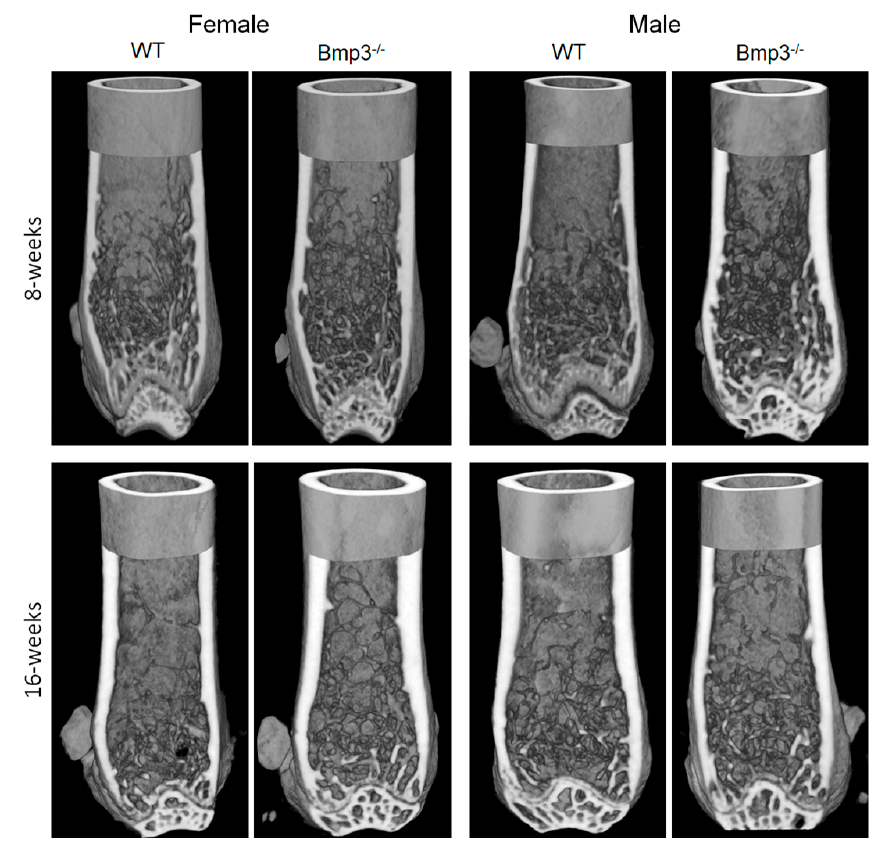
Figure 4. Femur cortical and trabecular bone render of 8-week- and 16-week-old female and male Bmp3 − / − and WT